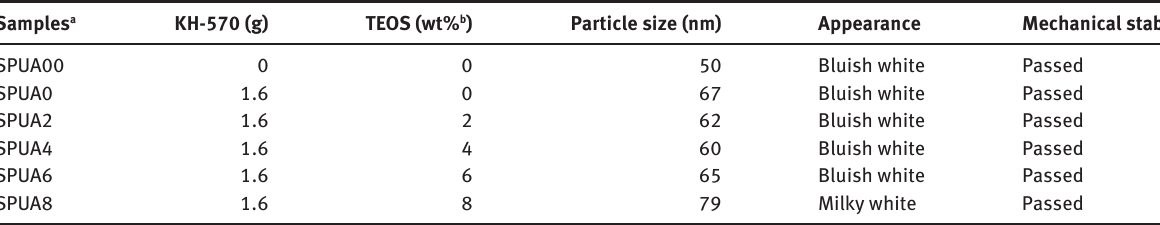
Table 1: Feed composition and characterization of SPUA emulsions with different TEOS weight %. Samples a